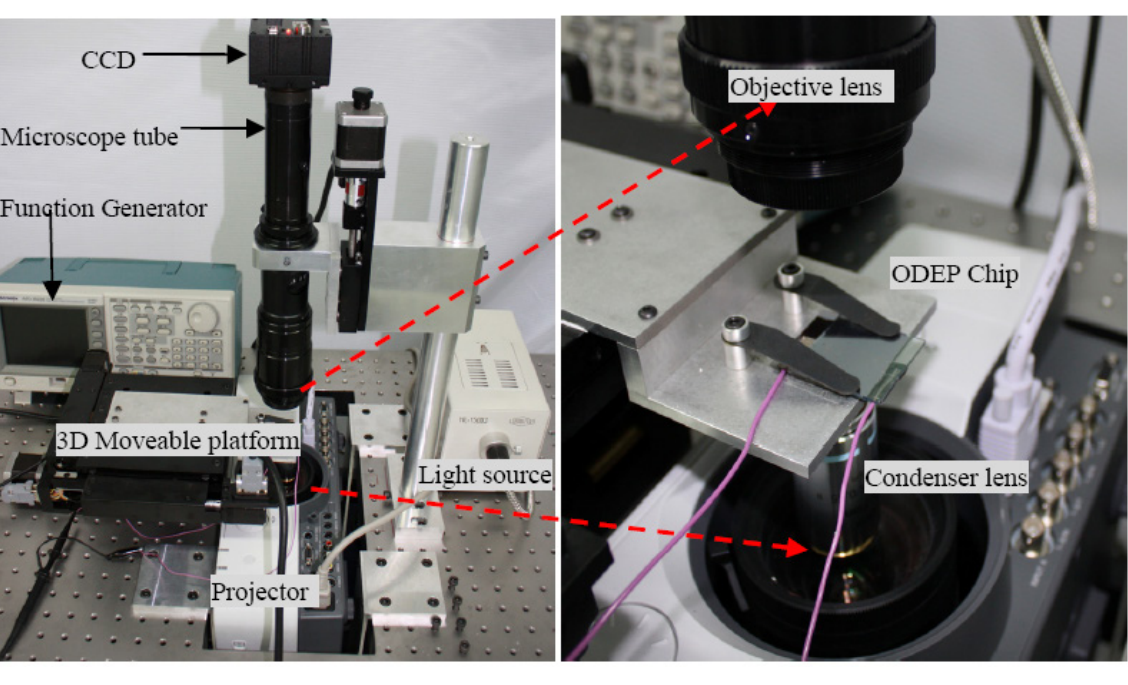
Figure 3. Photograph of the “ODEP System” used to fabricate micro/nano polymer structures described in this